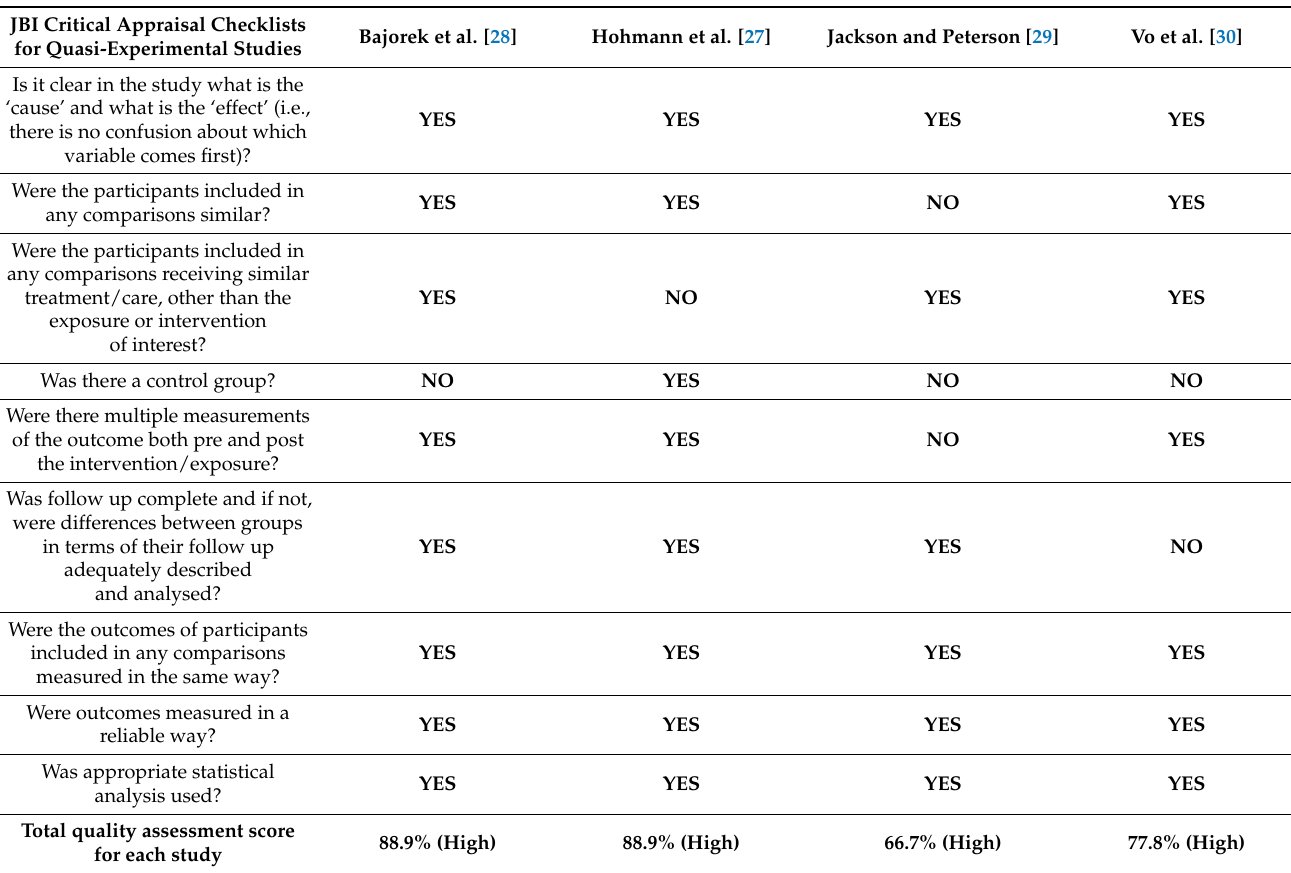
Table 3. Assessment of quasi-experimental studies (i.e., before–after or non-randomized study designs) using Joanna Briggs Institute (JBI) critical appraisal tools.